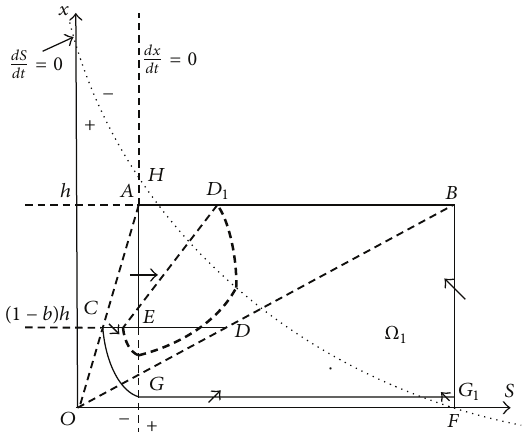
Figure 2: Illustration of (2) when 𝑅 > 1 , ℎ < 𝑥 ∗ , 𝑥(0) ≤ ℎ , and ≥ 𝑆 ∗ . 𝑆 𝐷